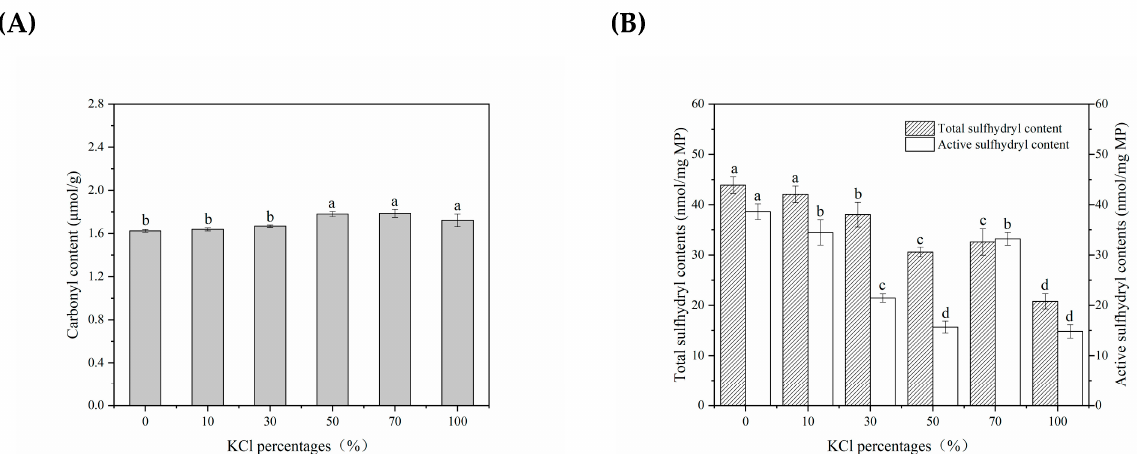
Figure 2. Change in oxidative stability of salted tilapia fillets as affected by different KCl replacements. ( A ) carbonyl content; ( B ) sulfhydryl group content. Values with different lowercase letters are significantly different at p <